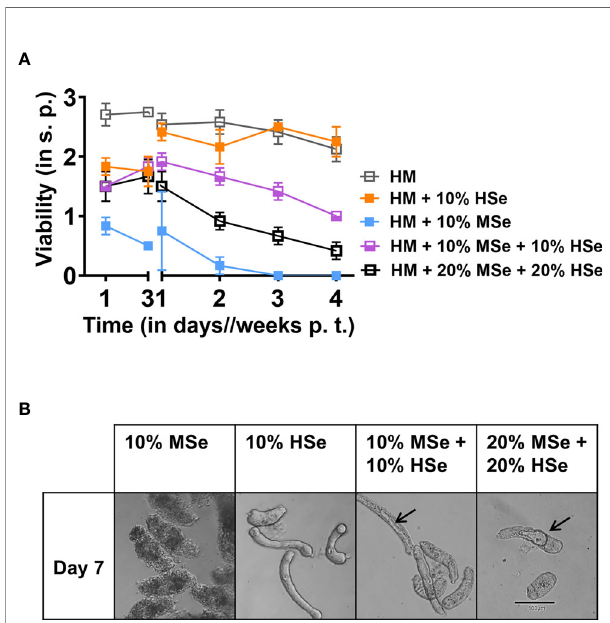
FIGURE 6 | Mouse serum factors can partially antagonize survival promoting effects of human serum. (A) NTS were cultured and maintained in the presence of 10% of mouse (MSe) or human (HSe) sera or adding both at 10- 20% and scoring was performed at the indicated time points. Hybridoma medium (HM) alone was used as a control. Each data point has been shown as mean ± SD of at least three technical replicates. (B) Morphological changes of NTS in presence of 10% MSe, HSe or in combination (10-20%). Representative photographs of NTS were taken using a digital camera fi tted with an inverted microscope (10x). Arrow indicates development of vacuoles. p.t., post transformation; s.p., scoring